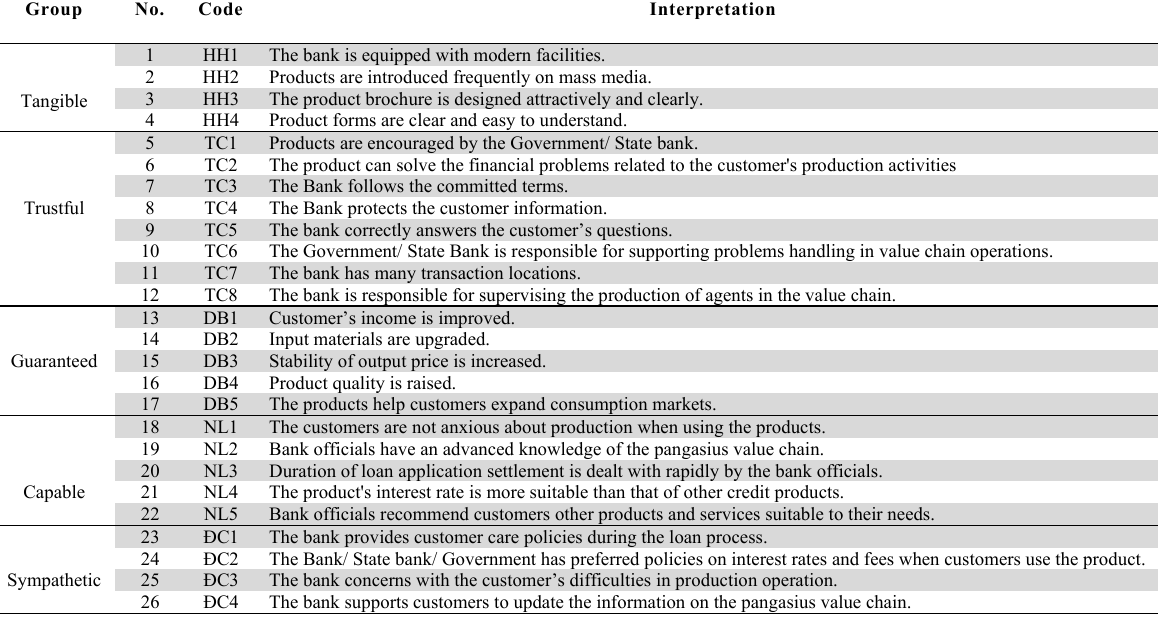
Variables measured on the SERVQUAL scale